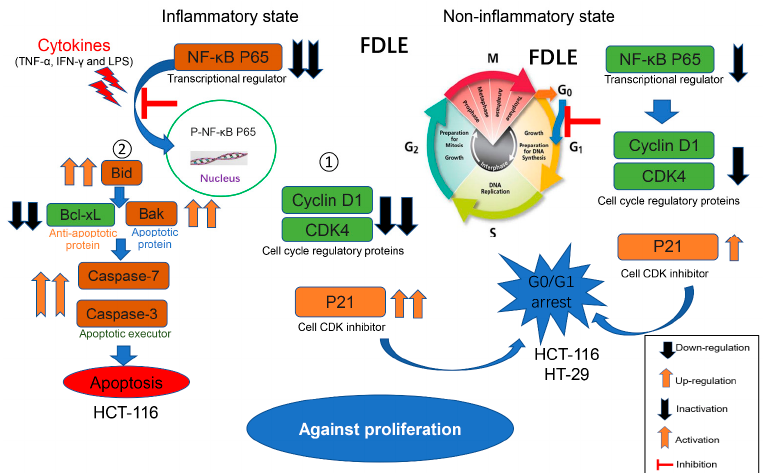
Figure 8. The different anti-proliferative mechanisms of FDLE on HCT-116 and HT-29 human colorectal cancer cell lines in non-inflammatory and inflammatory conditions. Supplementary Materials: The following supporting information can be downloaded at: www.mdpi.com/xxx/s1, File S1: The whole western blots; Table S1: IC 20 and IC 50 of FDLE on HCT- 116 and HT-29 colorectal cancer cell lines, Table S2: The % inhibition of FDLE on colony formation of HCT-116 and HT-29 colorectal cancer cell lines, Table S3: The % increasing of GO/G1 phase in HCT-116 and HT-29 colorectal cancer cell lines treated by FDLE, Table S4: The % relative change of proteins related to cell proliferation in HCT-116 and HT-29 human colorectal cancer cell lines by FDLE, Table S5: The % increasing of apoptosis in HCT-116 and HT-29 human colorectal cancer cell lines by FDLE, Table S6: The % relative change of proteins related to apoptosis in HCT-116 and HT- 29 human colorectal cancer cell lines by FDLE. Author Contributions: Conceptualization, R.H., P.P. and T.C.; methodology and investigation, R.H., W.C., B.C., P.T. and T.C.; software, R.H. and S.S.; writing—original draft preparation, R.H. and T.C.; writing—review and editing, S.S. and T.C.; supervision, P.P. and T.C.; project administra- tion, T.C.; funding acquisition, P.P. and T.C. All authors have read and agreed to the published version of the manuscript. Funding: This research was funded by The Agricultural Research Development Agency (Public Or- ganization), Thailand, funding number CRP6105022130. Institutional Review Board Statement: Not applicable. Informed Consent Statement: Not applicable. Data Availability Statement: The data presented in this study are available on request from the corresponding author. Acknowledgments: The authors would like to extend our sincere thanks to Jirarat Karinchai for his technical assistance with immunoblotting. Conflicts of Interest: The authors declare no conflict of interest.